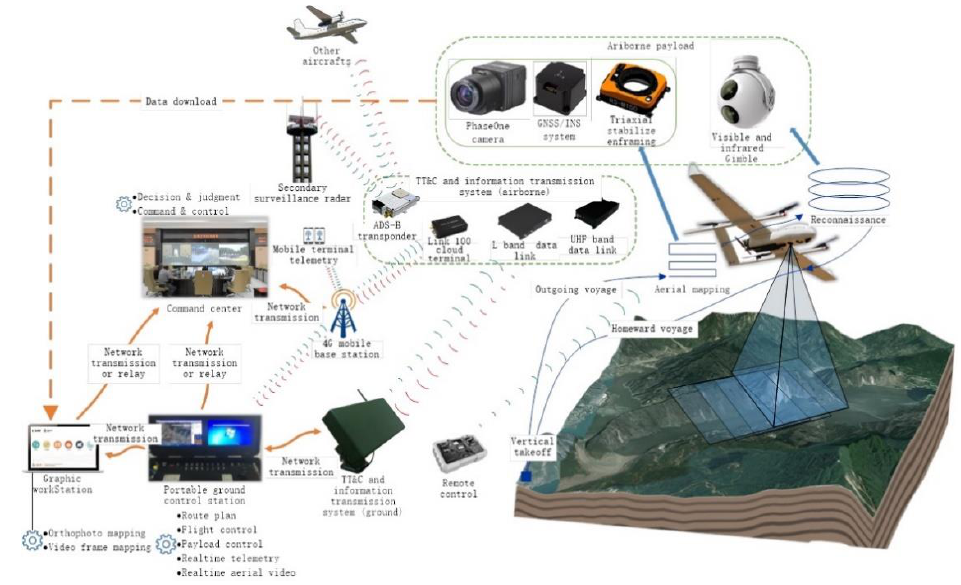
Figure 2. Workflow of fixed wing VTOL UAV